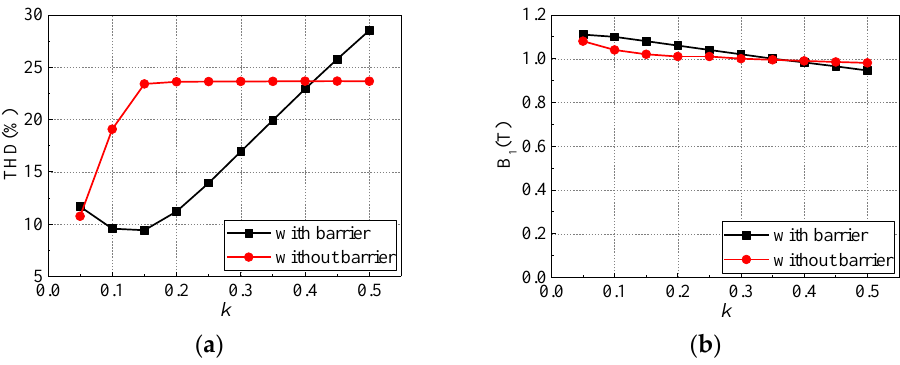
Figure 6. The comparison of THDs and fundamental amplitudes of air gap flux density of TLST AFIPM machines with and without flux barriers: ( a ) THD comparison; ( b ) fundamental amplitude comparison.